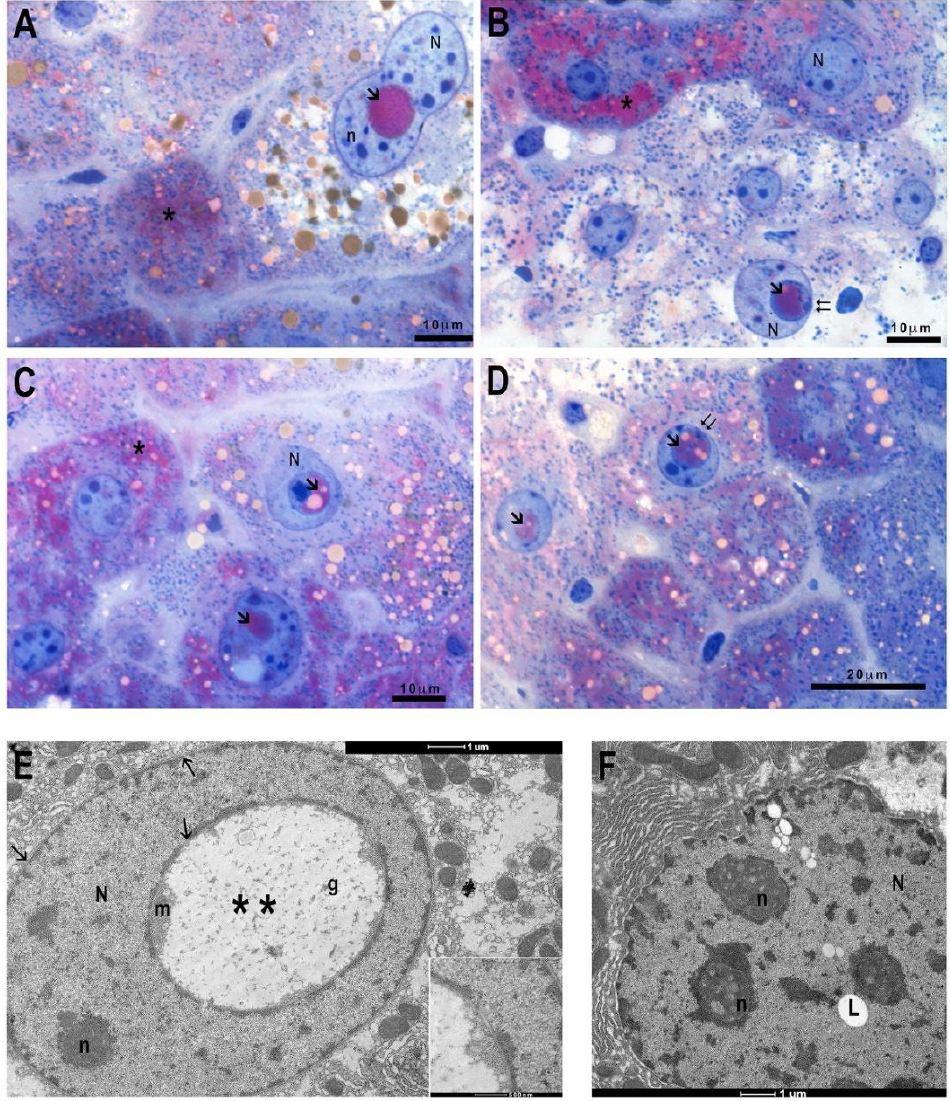
Figure 3. Morphological features of control and BTBR mice liver. PAS staining of BTBR mice liver ( A – D ). Some hepatocytes show nuclear inclusions (arrow), with PAS-positive cytoplasm and lipid drops, which at some point maintains contact with the nuclear envelope (double arrow). Transmission Electron Microscopy micrographs of BTBR mice liver ( E , F ) highlighting nuclear inclusions (double asterisks) with glycogen (g) or lipid droplets (L). N: nucleus; n: nucleolus; asterisk: PAS positivity. ( A – D ): 100 × magnification; ( E , F ): 7000 ×